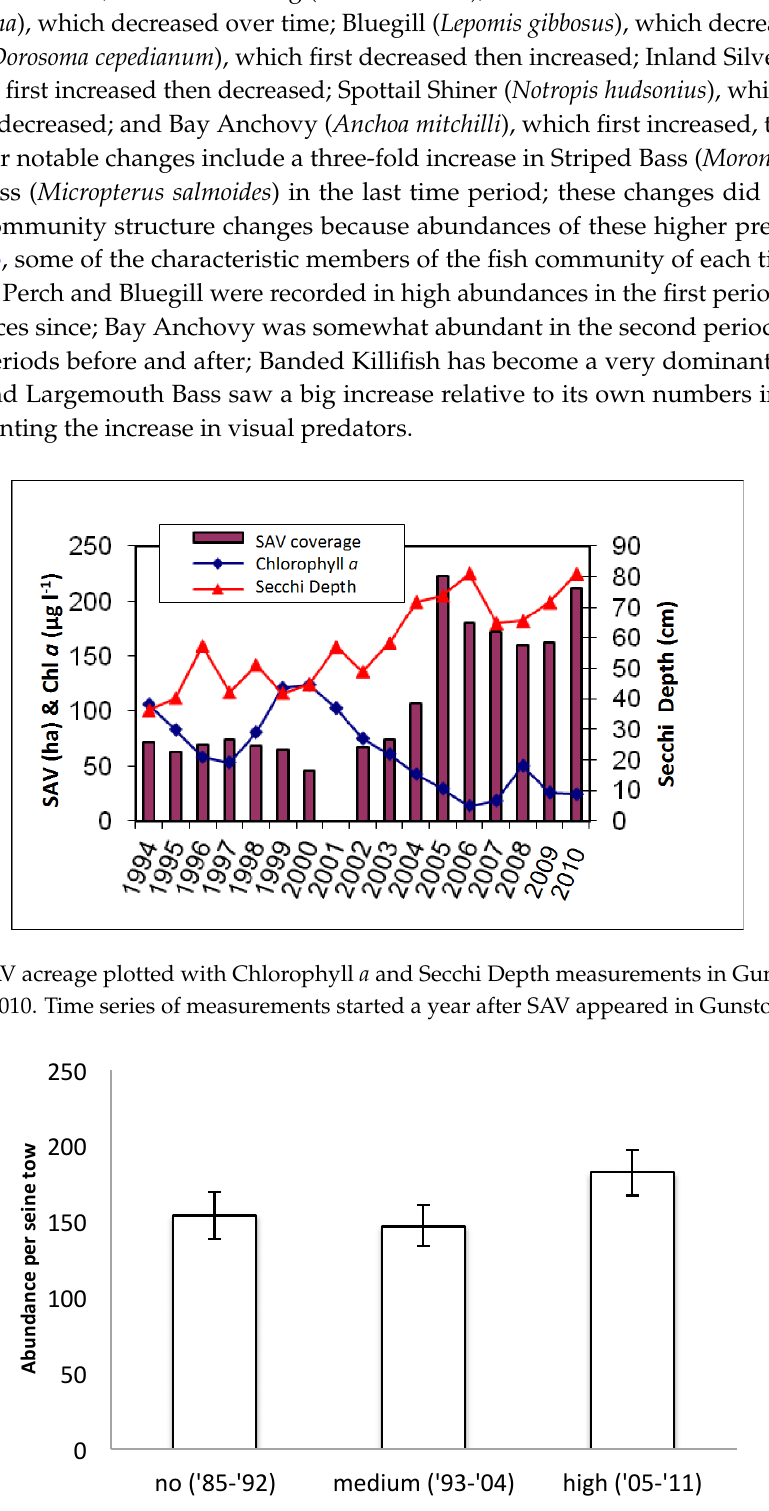
Figure 5. Non-metric multidimensional scaling plot of fish community structure. Each symbol represents the fish community structure in Gunston Cove of one year based on relative abundance. The color-coding of the years represents the amount of SAV cover in those years categorized as ‘no’, ‘medium’, and ‘high’ cover (see Figure 2). The asterisks in the legend indicate that the fish community structure between those three time periods was significantly different from each other.